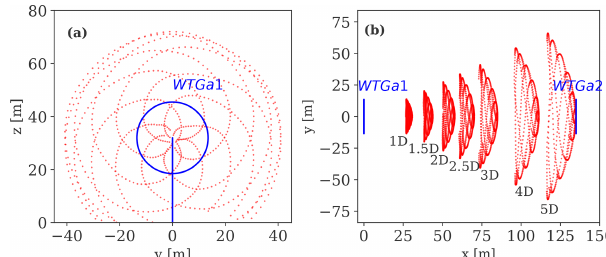
Figure 2. A schematic view of the SpinnerLidar’s scanning pattern: (a) a front view at 2.5 D in the wake; (b) a top view including all scanned distances behind the WTGa1 , which is depicted by solid blue lines. The WTGa2 is also